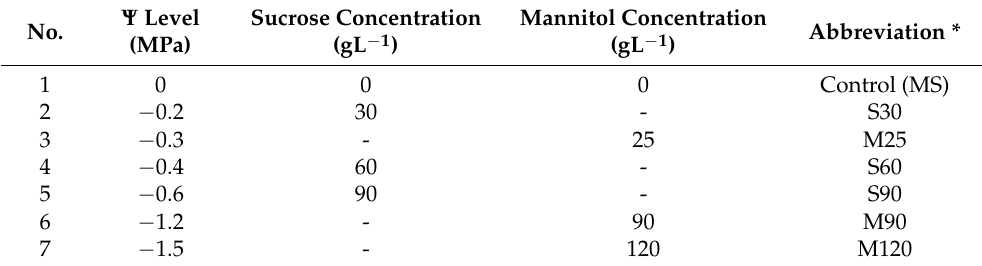
Table 2. Osmotic treatment number (No.), water potential ( Ψ level) and the amount and type of osmotic agent used (Sucrose or Mannitol) and associated treatment abbreviations used in the eight-week experiment on black locust